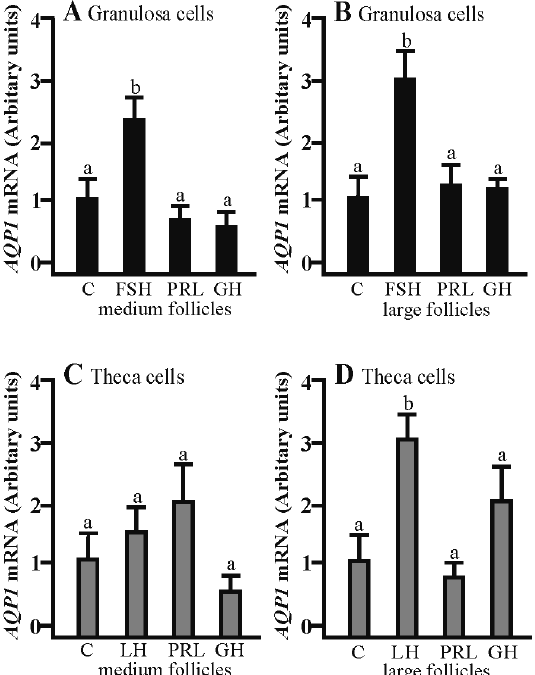
Figure 1. Effect of follicle-stimulating hormone (FSH), luteinizing hormone (LH), prolactin (PRL) and growth hormone (GH) on Aqp1 expression in medium and large follicles. ( A , B ) in the granulosa cells and theca cells ( C , D ). FSH, follicle-stimulating hormone; LH, luteinizing hormone; PRL, prolactin; GH, growth hormone. The mRNA expression level of Aqp1 was determined by real-time PCR and normalized to the expression of GAPDH and PPIA . Values are expressed as means ± S.E.M from five separate experiments, each performed in triplicates ( p < 0.05 compared with controls). Statistically significant differences between treatments are indicated by different letters (a, b). C: control.